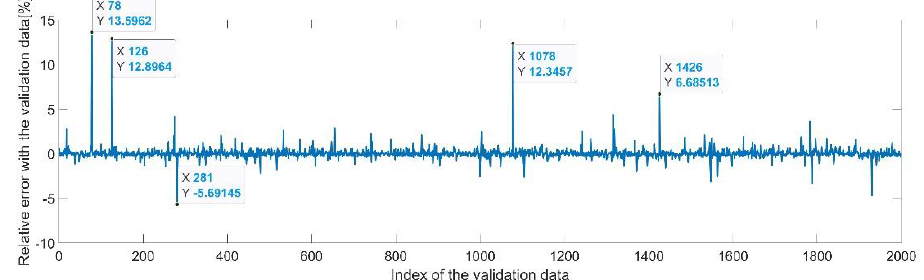
Figure 25. Relative errors between the target values and the predicted values for 𝑞 5 .